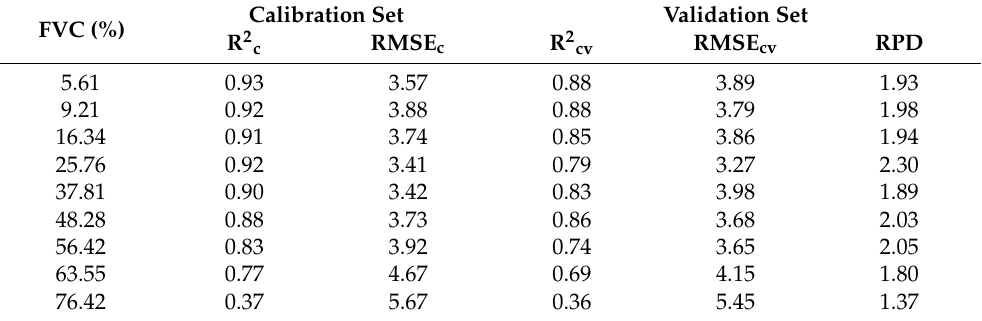
Table 2. Estimation accuracy of soil salt content by NMF-extracted spectra at different FVCs.